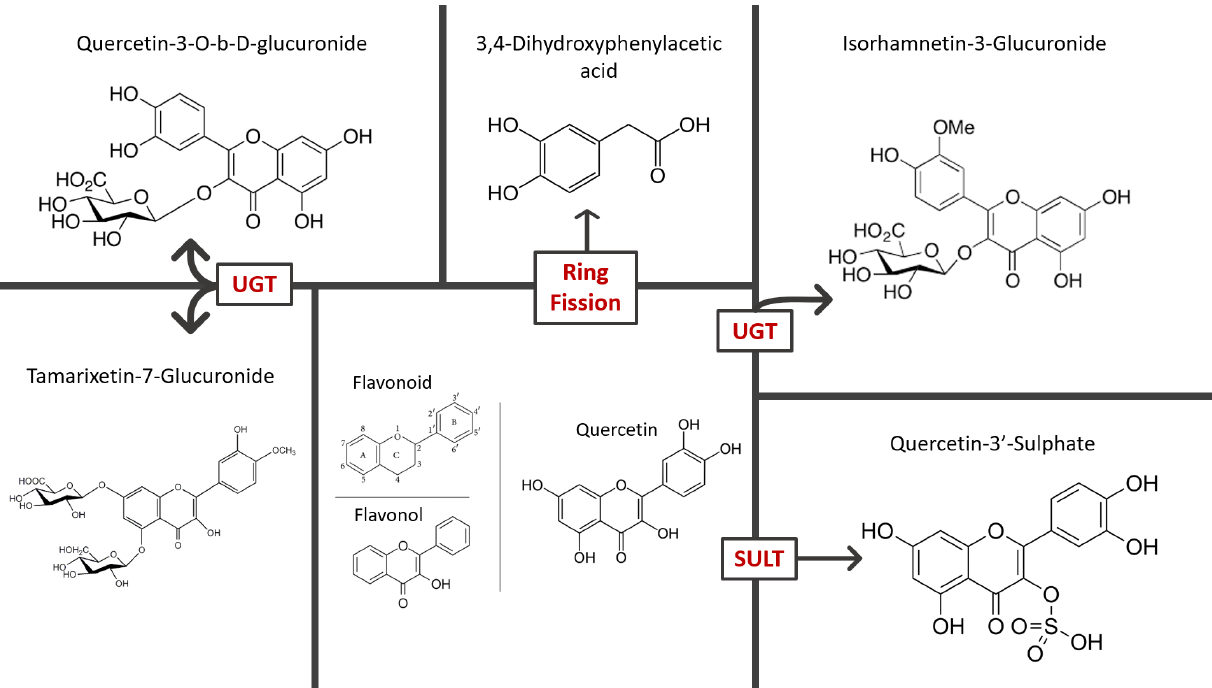
Figure 2. Chemical structure of quercetin and its main derivatives (metabolites).